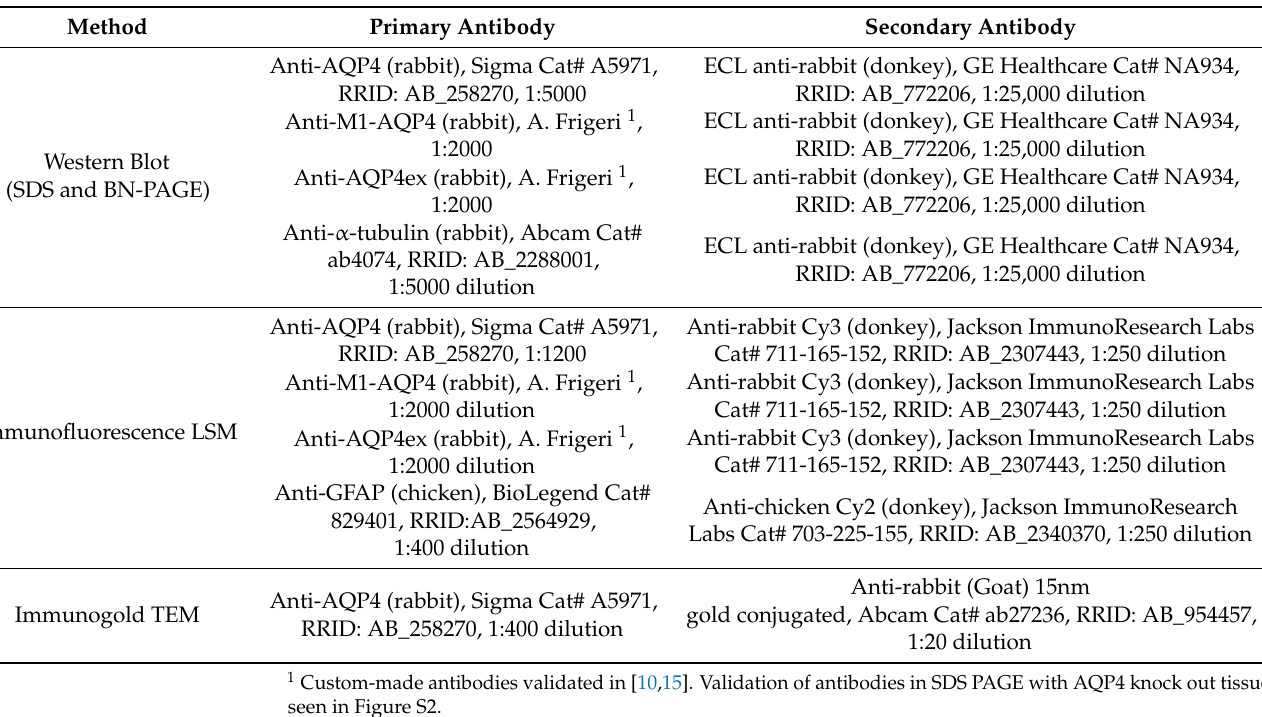
Table 1. Overview of antibodies